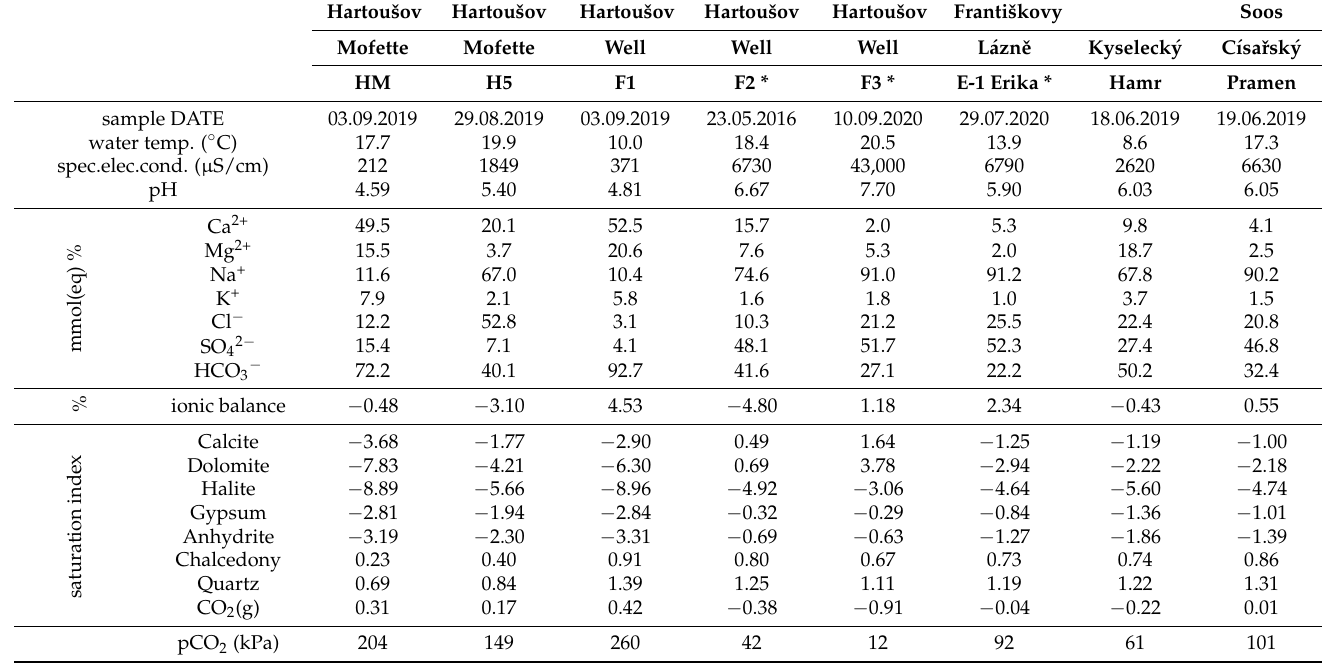
Table A1. Properties of the Hartoušov fluids compared to Františkovy L á znˇe, Kyseleck ý hamr, and Soos C í saˇrsk ý pramen. Saturation indices calculated with PhreeqC.